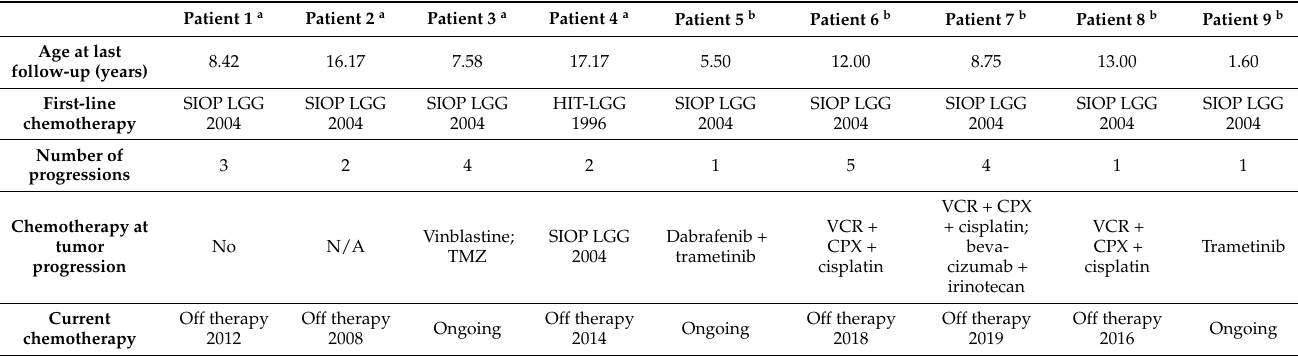
Table 2. Long-term outcomes of patients affected by optic pathway glioma and diencephalic syn-